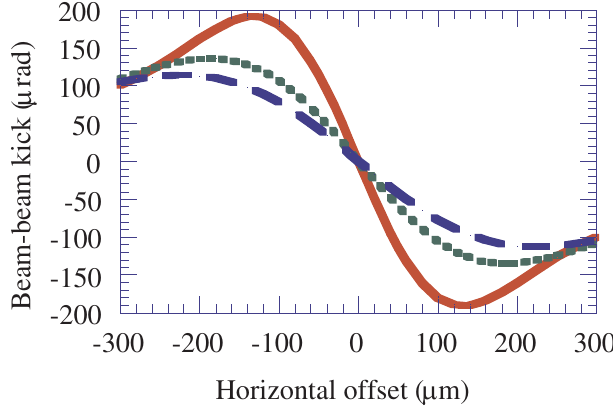
FIG. 2. (Color) Beam-beam kicks as a function of the horizontal offset, assuming an effective horizontal beam size of 100 (cid:11) m (red solid line), 141 (cid:11) m (green dotted line) and 170 (cid:11) m (blue dashed line). The effective vertical size is a constant value of 2 : 83 (cid:11) m for all cases under the same bunch